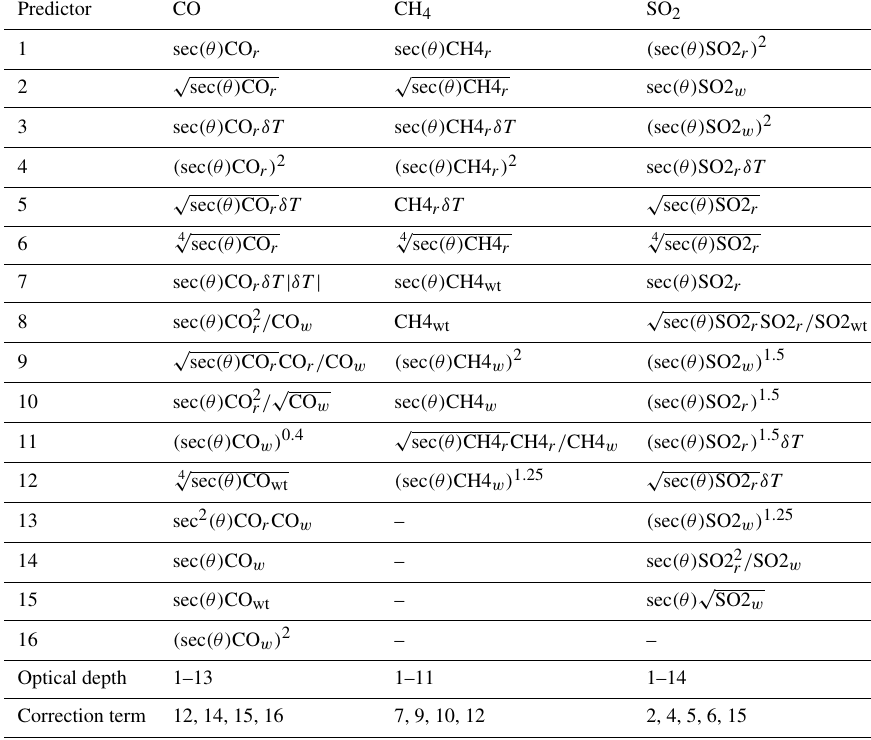
Table A4. CO, CH 4 , and SO 2 predictors and predictor lists for the optical depth and correction